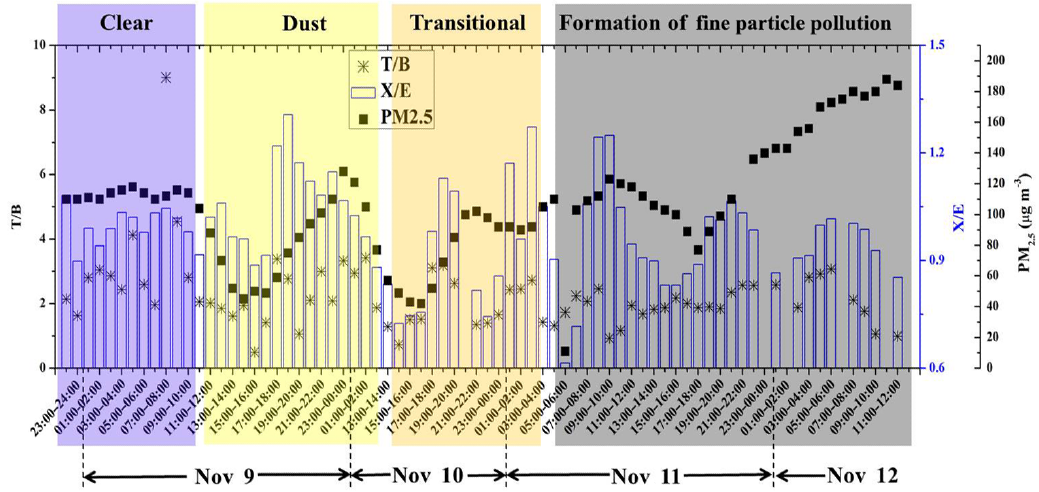
Figure 2. Variations in the ratios of indicator volatile organic compound low loading (VOC) species (toluene/benzene (T / B) and m -, p - xylene/ethylbenzene (X / E)) and fine particle loadings during the study period.